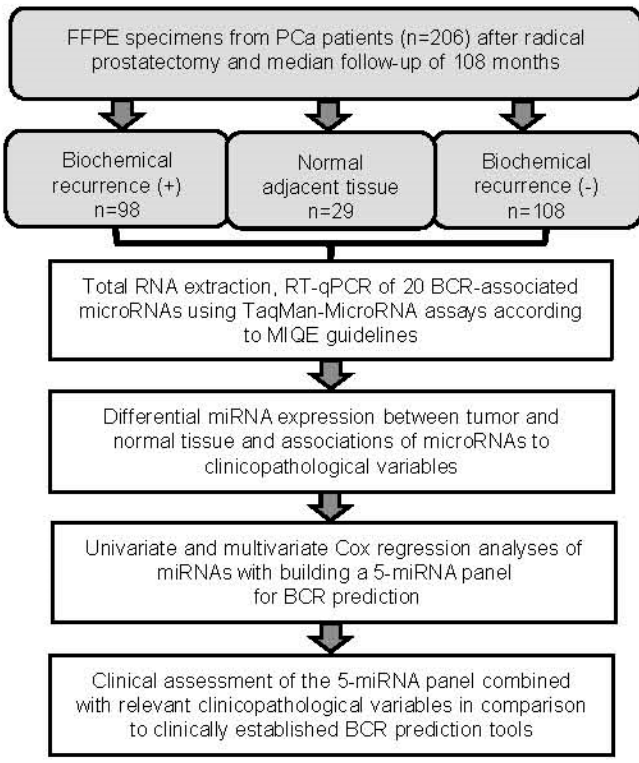
Figure 1. Flowchart of the study. Fourteen and 15 out of 29 adjacent normal samples were from patients without and with BCR, respectively. Between these two sample groups, expression of all microRNAs of interest in this study shown in Figure 2 did not significantly differ (Mann-Whitney U - test, p- values between 0.198 and 0.983) and the combined 29 samples were therefore used as "Normal adjacent tissue". Abbreviations: FFPE, formalin-fixed, paraffin-embedded; PCa, prostate carcinoma; BCR, biochemical recurrence; RT-qPCR, reverse transcription real time quantitative polymerase chain reaction; MIQE, Minimum Information for Publication of Quantitative Real-time PCR Experiments.